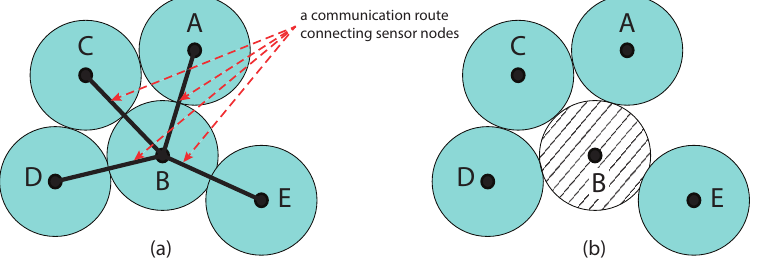
Figure 1. Sensor coverage hole and communication route failure example: ( a ) connected nodes, ( b ) communication route